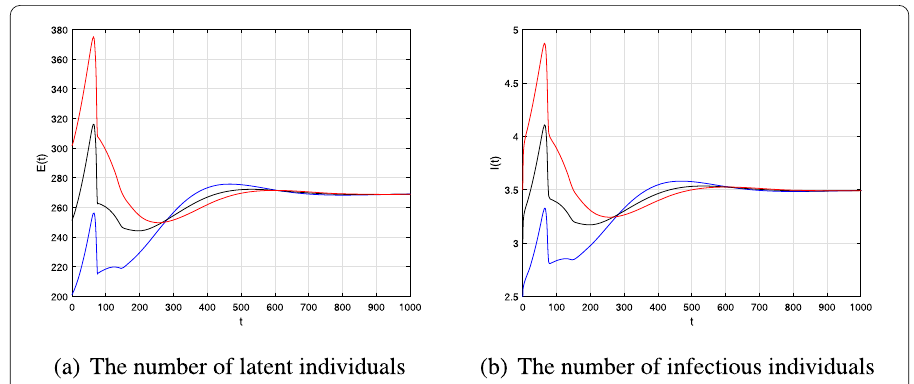
Figure 1 The global asymptotical stability of the endemic equilibrium E ∗ when R 0 > 1, where E ( t ) represents the latent individuals, and I ( t ) represents the infectious